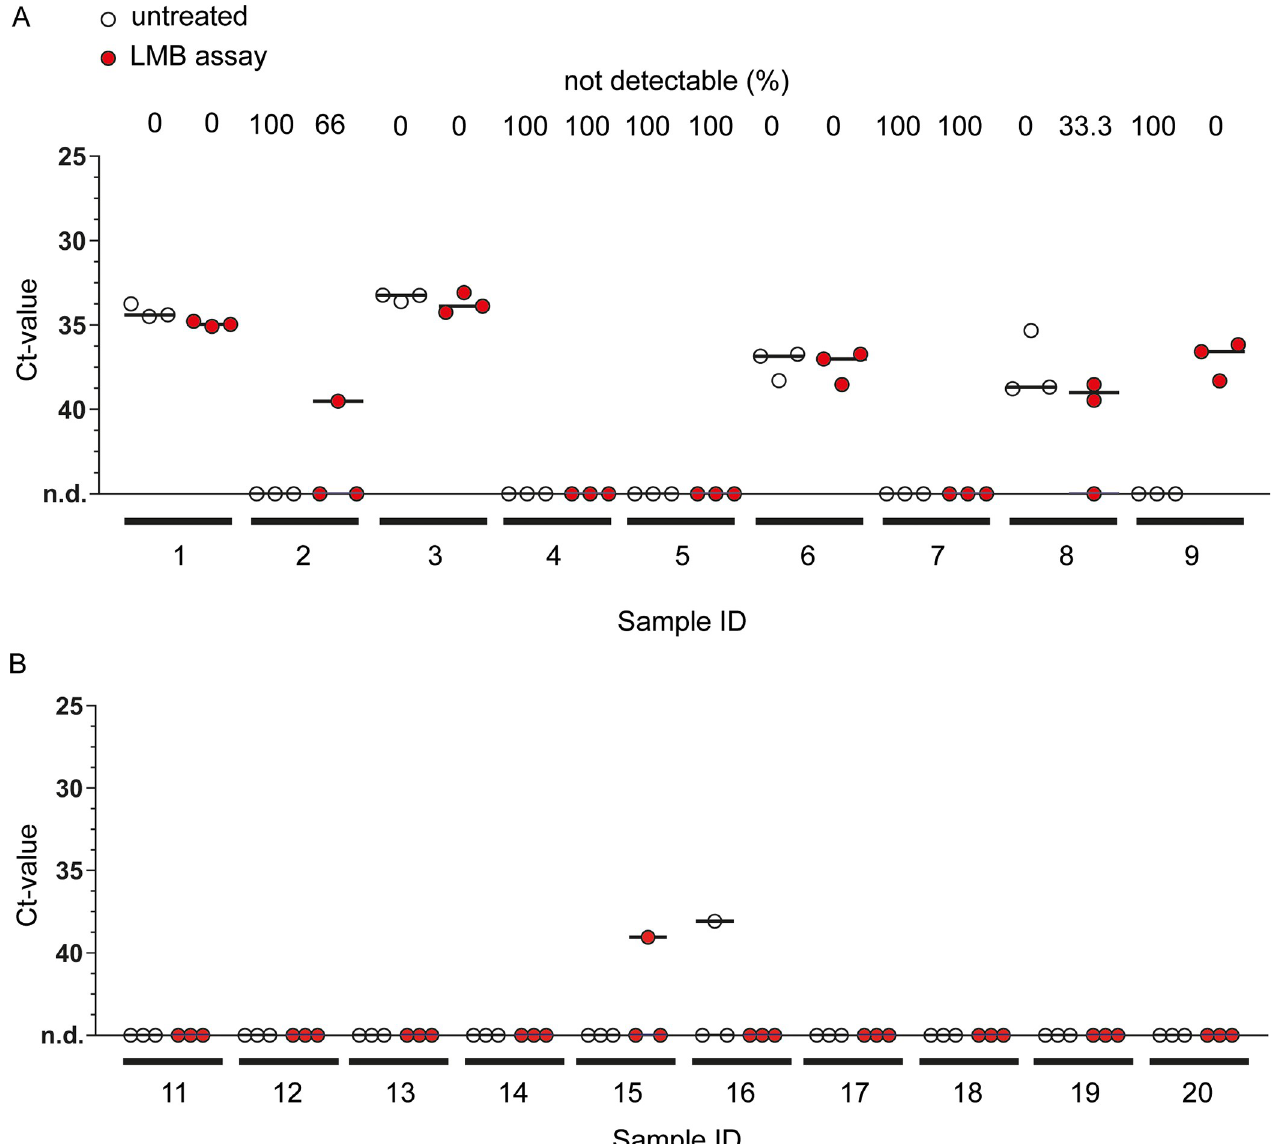
Fig 4. The effect of LMB assay on qPCR-based detection of Mtb in saliva from TB patients and healthy subjects (cohort #1). Saliva was collected from TB patients (A) and healthy subjects (B). Samples were divided into two fractions that were either left untreated or were incubated with LMBs (LMB assay) before undergoing heat treatment, DNA isolation, and qPCR analysis. Analysis of three technical replicates per condition is shown with the line at median. For TB patients (A), the percentage (%) of samples in which no signal could be detected (not detectable, n.d.) is given above the graph. Statistical analysis was conducted with a non-parametric analysis of variance for repeated measurements comparing untreated vs LMB assay-treated samples (A): p = 0.7506.